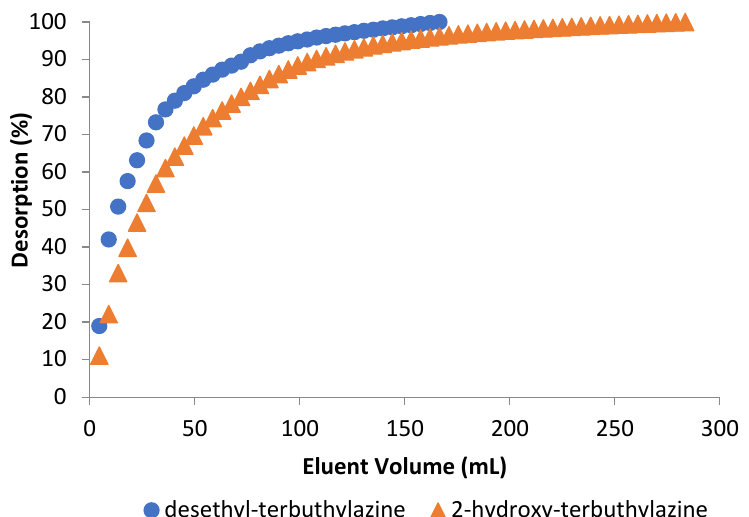
Figure 10. Desorption of terbuthylazine metabolites using ethanol.